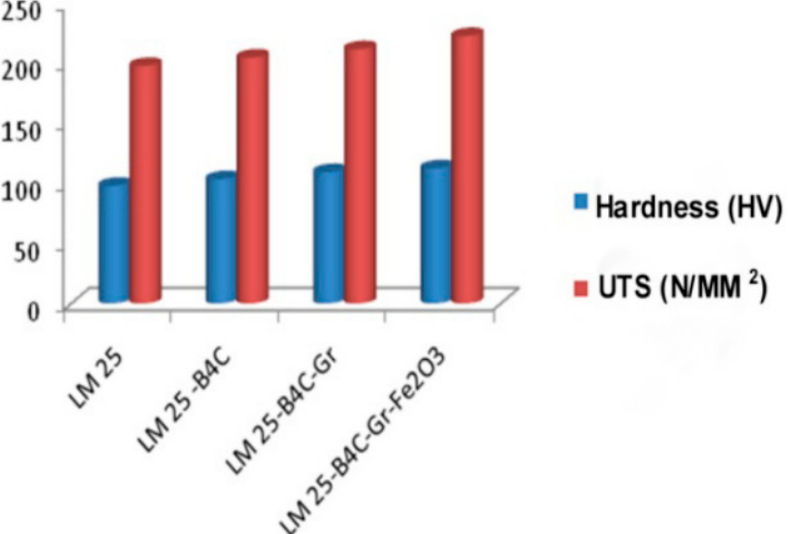
Figure 8. Variation of hardness and UTS of the samples [64].